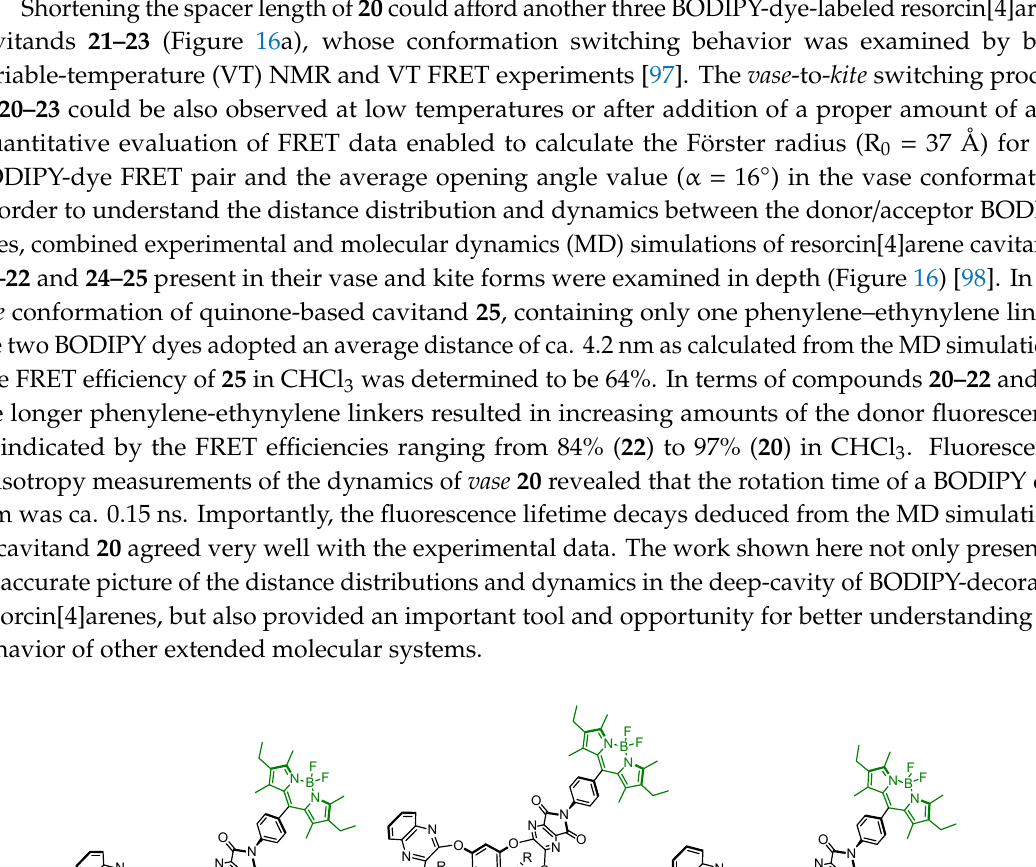
Figure 15. Chemical structure of ( a ) BODIPY-functionalized oligo(phenylene ethynylene)s 18a–c and ( b ) BODIPY-decorated resorcin[4]arenes 19 and ( c ) 20 together with its models the contracted (vase) and expanded (kite) states. Reproduced with permission from Reference [95]. Copyright 2005 John Wiley and Sons.